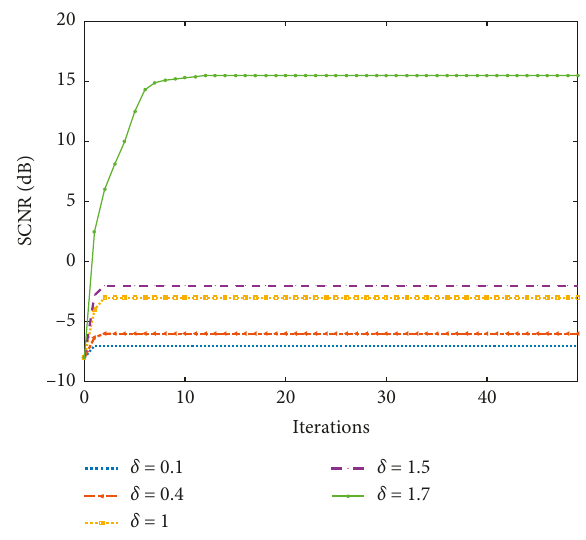
Figure 3: SCNR vs. number of iterations for continuous phase